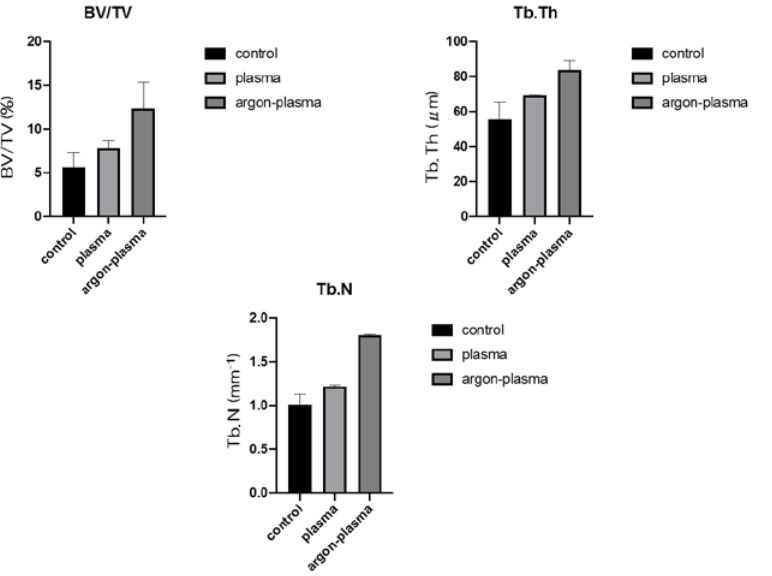
Figure 10. Furthermore, the ratio of bone mass to total mass (BV/TV), average trabecular number (Tb.N), and average trabecular thickness (Tb.Th), were the highest, significantly, for the material surface of the argon plasma-treated group, among all three groups. The implants promoted osteo- genic activity ( p < 0.05).